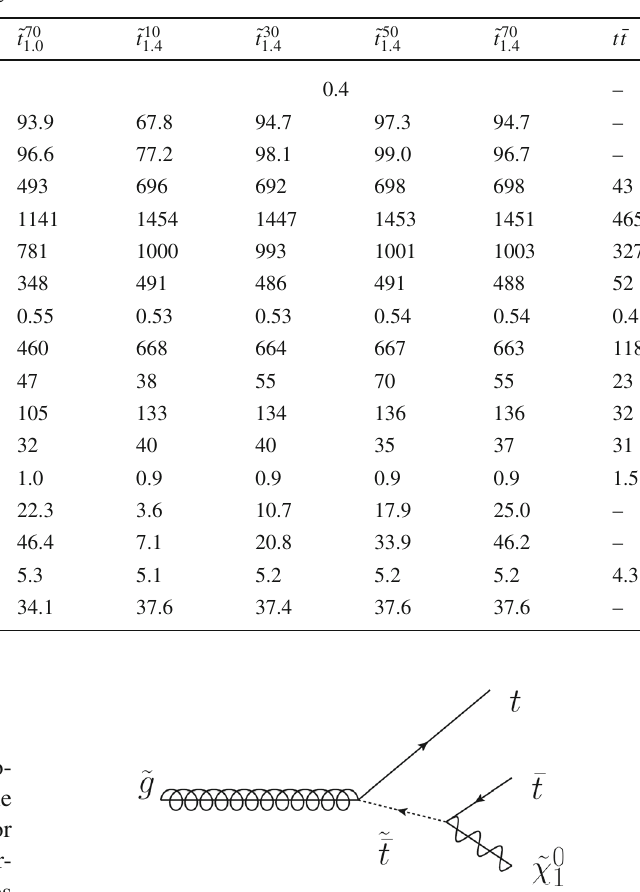
Table 6 Mean values of some observables and number of events with top quarks decaying in the tracker volume for the eight benchmarks of the stop squark pair production. We remind that R ≥ 1 displaced t corre-